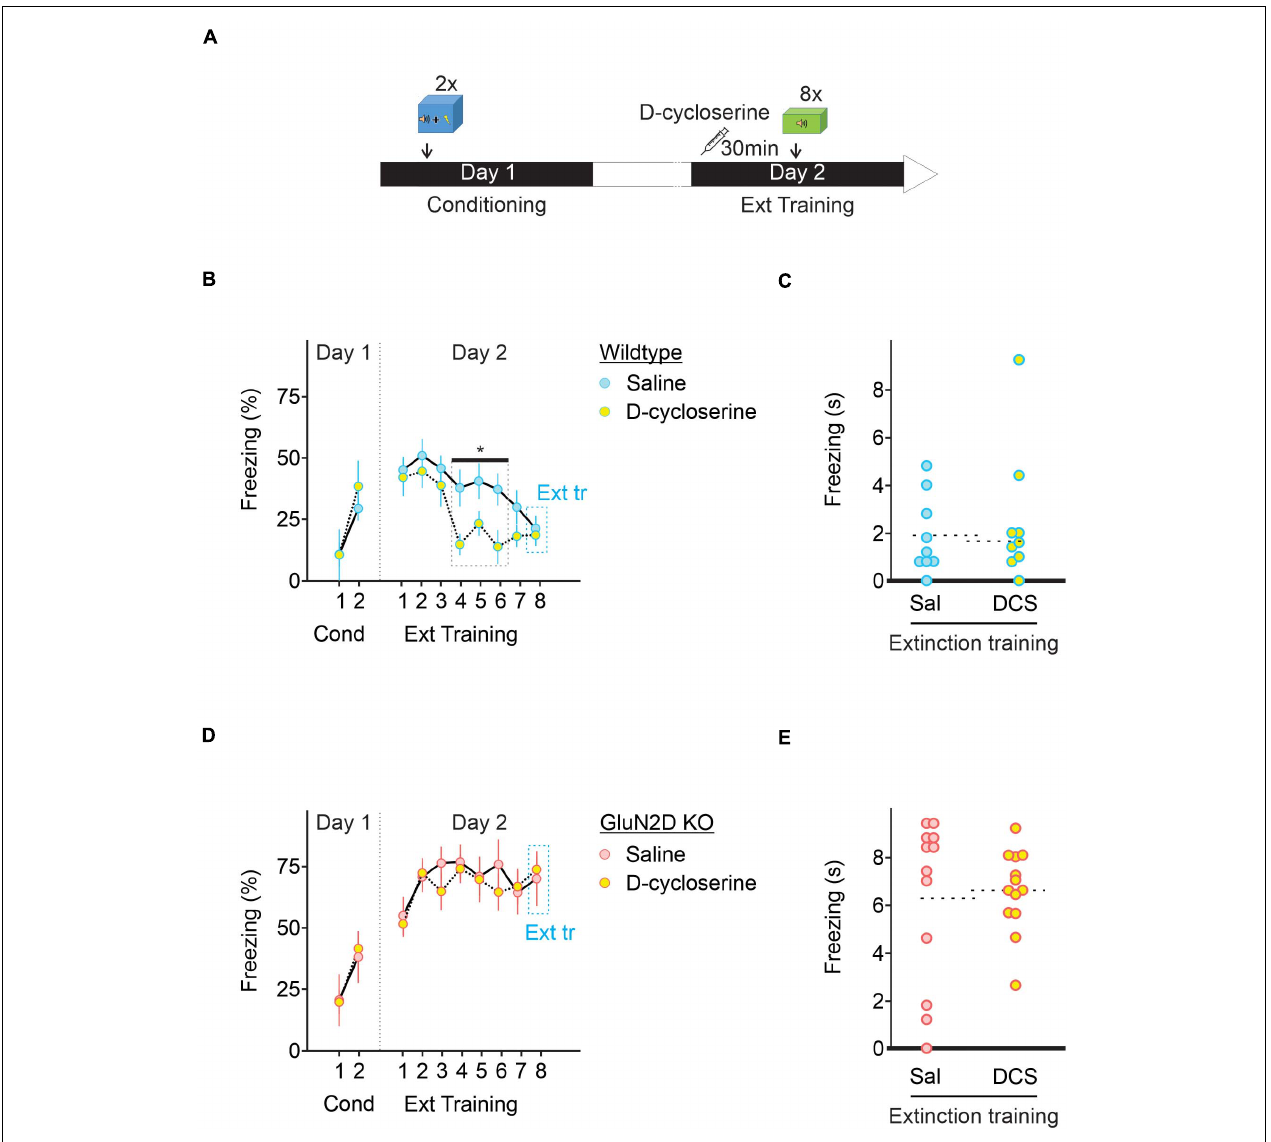
FIGURE 5 | D-cycloserine fails to rescue extinction learning in GluN2D KO mice. (A) Wildtype and GluN2D KO mice were injected with D-cycloserine (DCS, 10 mg/kg; i.p.) or saline (Sal), 30 min before fear extinction learning. (B) Freezing response in wildtype mice injected with either saline (blue symbols, n = 9) or D-cycloserine (yellow symbols, n = 8) showed that D-cycloserine administration significantly accelerated extinction learning on tones 4–6. (C) Individual values for freezing response during extinction training. (D) Freezing response in GluN2D KO mice injected with either saline (red symbols, n = 12) or D-cycloserine (yellow symbols, n = 13) showed that D-cycloserine administration failed to accelerate extinction learning. (E) Individual freezing values at the end of the extinction training. * P < 0.05. Values are mean ± SEM. Statistical analysis values can be found in the Supplementary Table 1